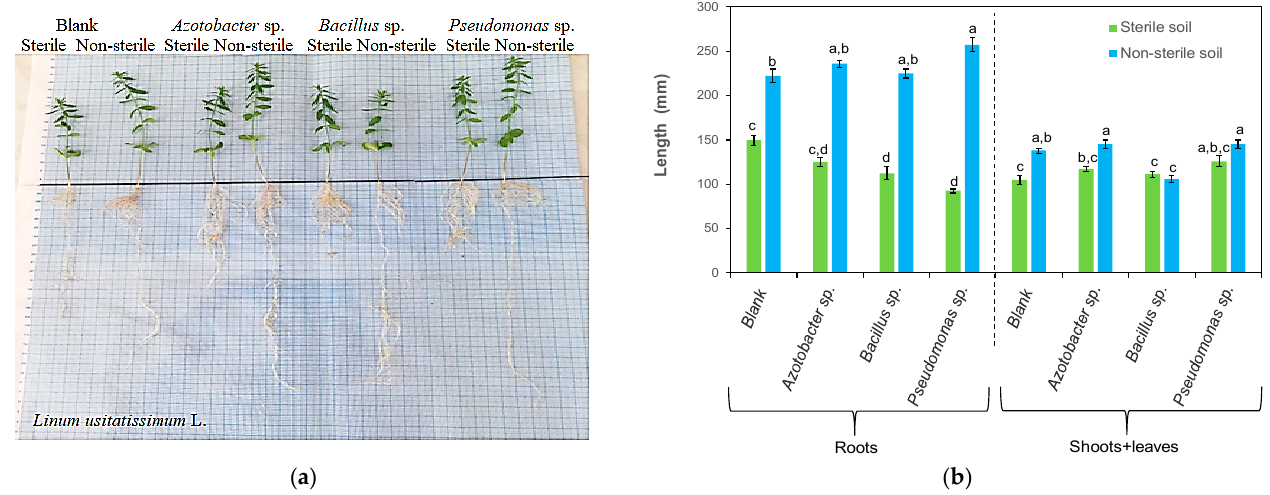
Figure 8. Effects of Azotobacter , Bacillus and Pseudomonas species on Linum usitatissimum L.: ( a ) visual aspect of plants and ( b ) the root and shoot/leaf length (error bars represent the experimental error; means that do not share a letter are significantly different according to the Tukey’s HSD test).